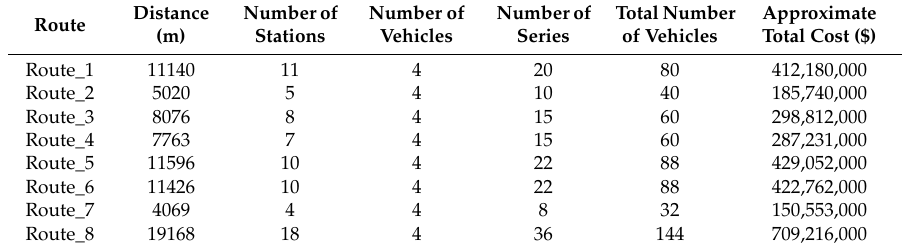
Table 1. Characteristic features of the routes.